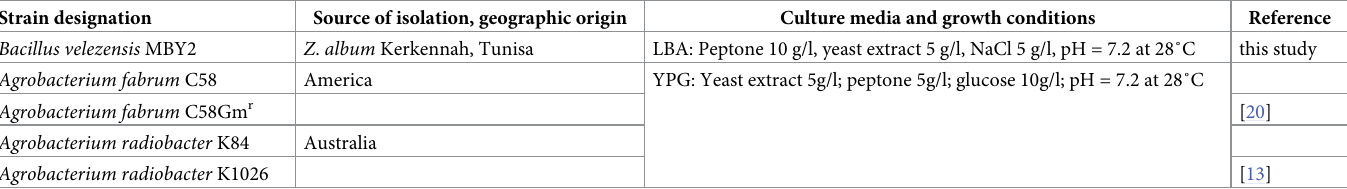
left open for 15 min in a laminar flow cabinet. One milliliter of A . fabrum C58 suspension (10 7 CFU ml -1 ) was mixed with 3 ml of LBA (0.6% agar) at 45˚C and quickly inoculated by spreading on the plates containing the isolate to be tested. Plates were incubated at 25˚C and checked after 24-48h for the appearance of inhibition haloes surrounding the putative antagonists’ spots. For the agar well diffusion method, one milliliter of A . fabrum bacterial suspension (10 7 CFU ml -1 ) was mixed with 3 ml of YPG (0.6% agar) at 45˚C and quickly spread on plates con- taining LB medium, in which 4 wells of 6 mm diameter were punched. The 24h pre-culture of MBY2 in LB broth were centrifuged at 15,000 rpm for 30 min to remove cell debris and filtered through a 0.2 μ m membrane filter, and then 100 μ l of each sample were filled into the wells. Plates were incubated at 25˚C for 48h and subsequently examined for inhibition haloes around wells to record their size.